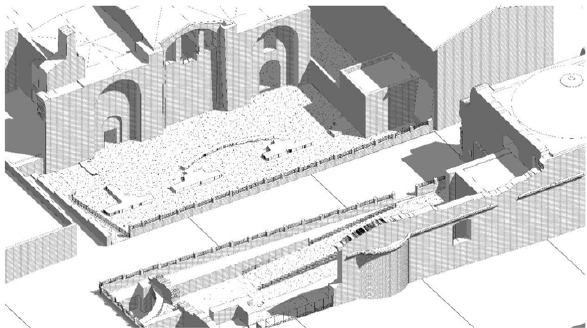
Figure 12 . First example of modeling to a LOD 200 of the Diocletian Baths complex, starting from the two-dimensional drawings and with integration of the point cloud created during the survey